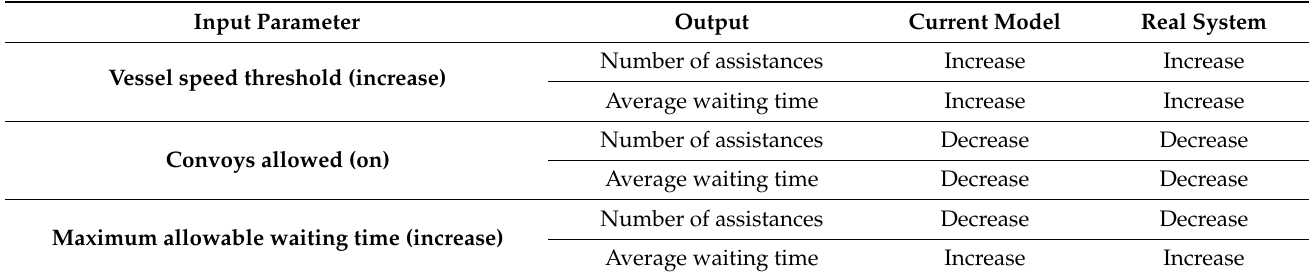
Table 6. Validation by parameter variation.